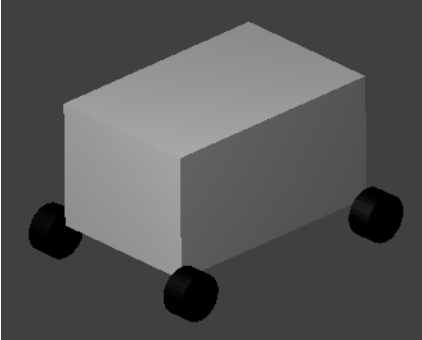
Figure 9. The simple virtual model created in Blender with Bullet